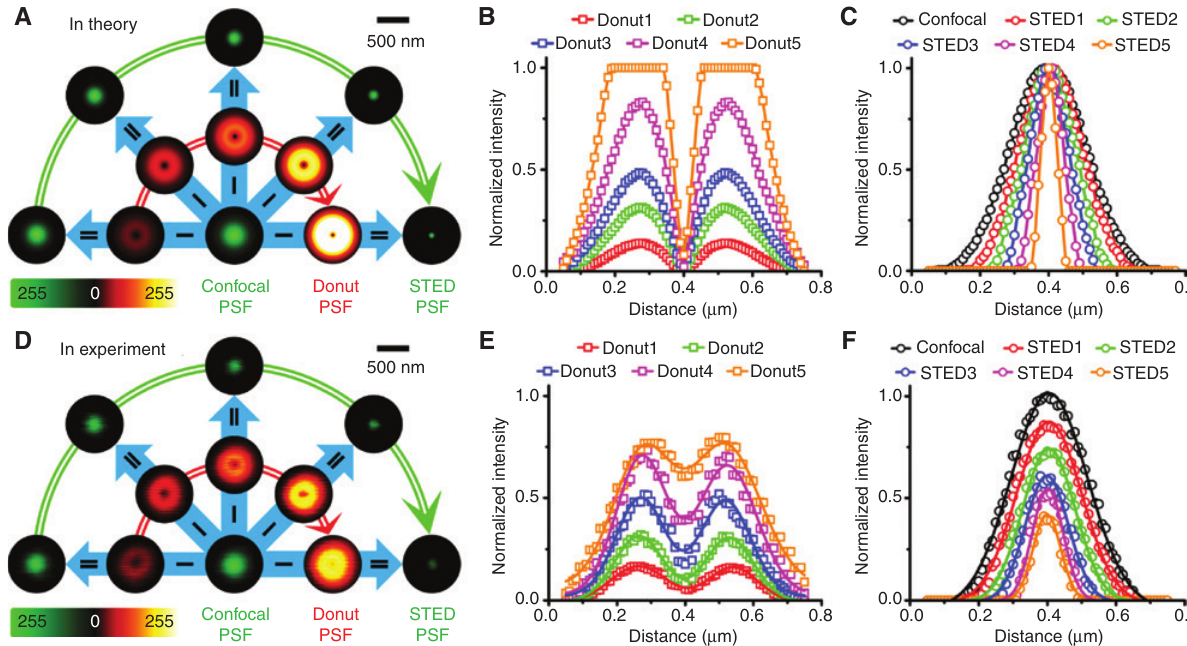
Figure 2: Comparison between theoretical simulations and experimental results of a donut PSF and a STED PSF. (A) Theoretical simulations of confocal, donut, and STED PSFs for increasing depletion power. (B) The intensity profiles of the donut PSF and (C) the STED PSF in (A). (D) Experimental results of the confocal, donut, and STED PSFs for increasing depletion power. (E) The intensity profiles of the donut PSF and (F) the STED PSF in